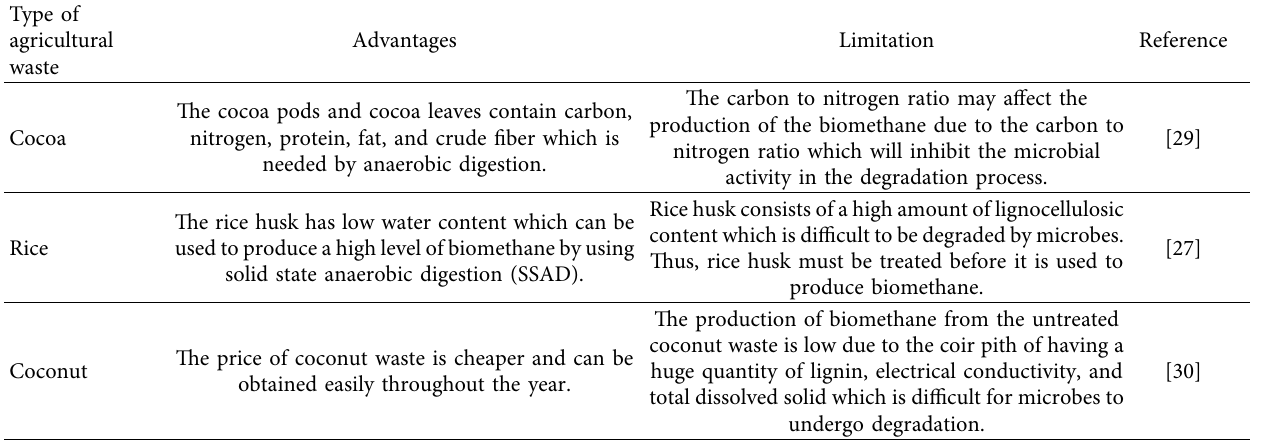
Table 3: Advantages and limitations of producing biomethane from different types of agricultural